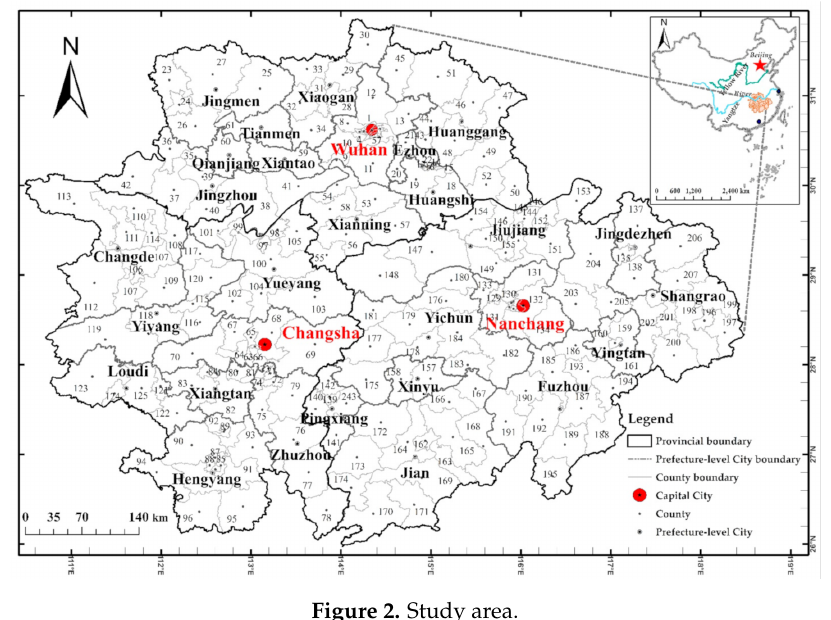
Figure 2. Study area.